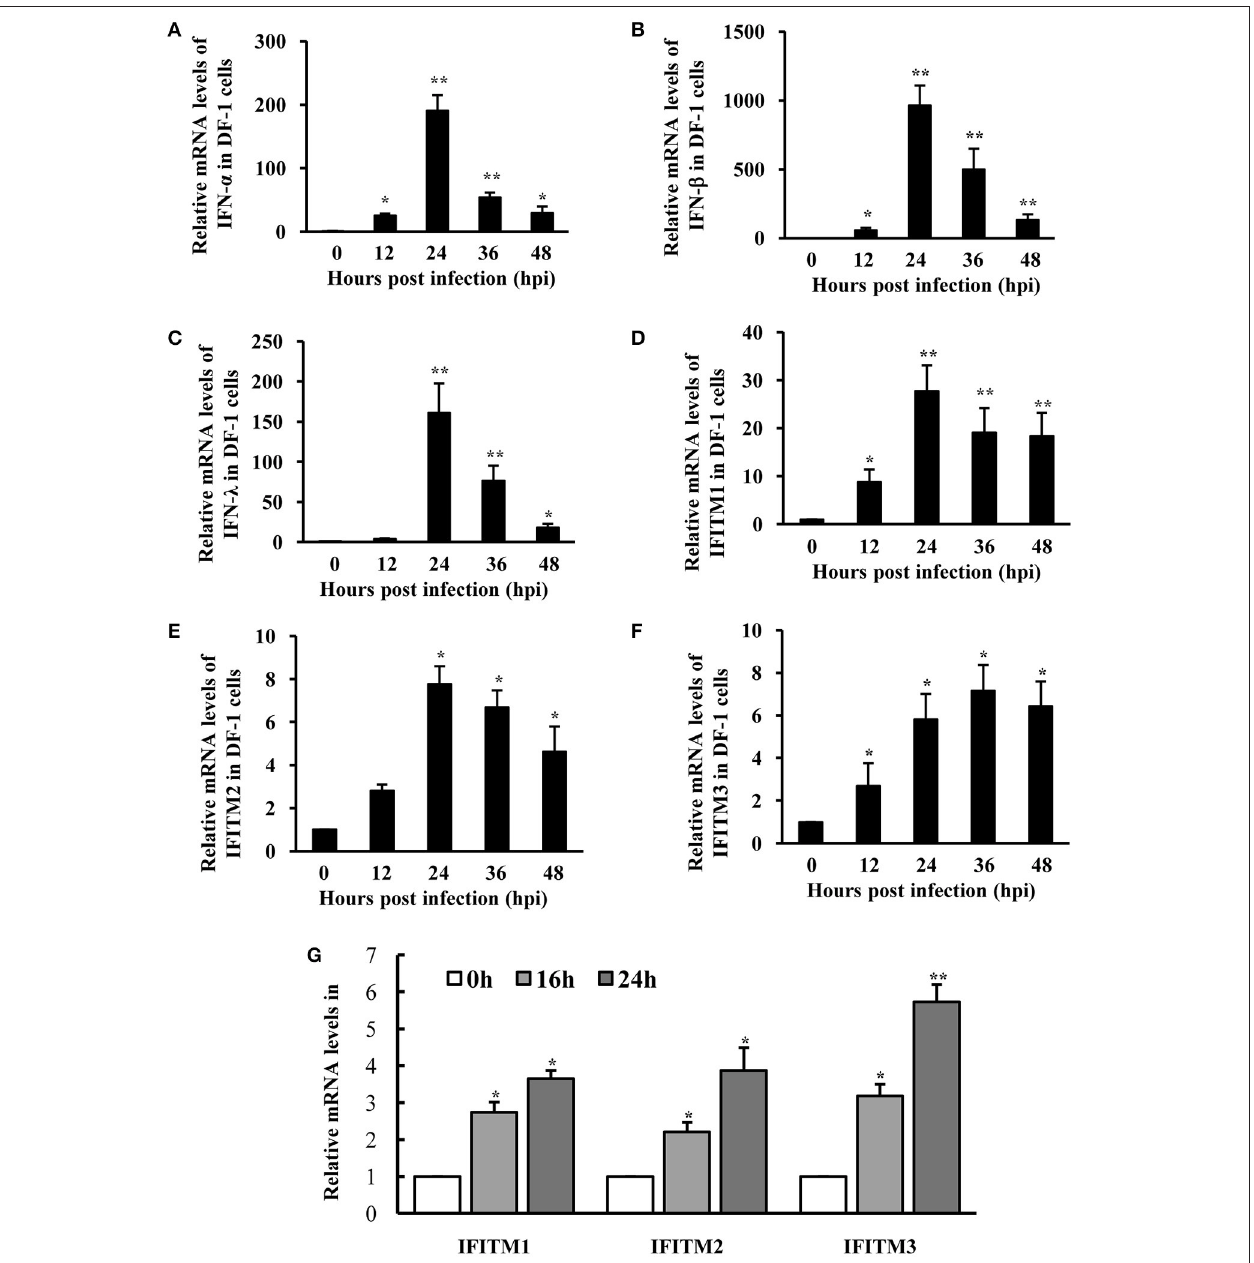
FIGURE 4 | IFITMs are significantly induced in DF-1 cells after ATMUV infection or treatment with IFN. DF-1 cells were infected with or without ATMUV at a MOI of 1.0 and harvested at 0, 12, 24, 36, and 48 hpi, respectively. qRT-PCR was performed to determine the relative mRNA expression of indicated IFNs (A–C) and IFITM (D–F) genes compared with that at 0 hpi. (G) DF-1 cells were treated with chicken IFNs (500 IU/mL) for 0, 16, or 24 h. qRT-PCR was performed to determine the relative mRNA expression of IFITM genes compared with that without IFN treatment. The mRNA levels were normalized to the endogenous β -actin level. Plotted are the average levels from three independent experiments with three replicates per experiment (means ± SD ). Statistical significance was determined by one tail Student’s t -test analysis. * P < 0.05, ** P < 0.01.